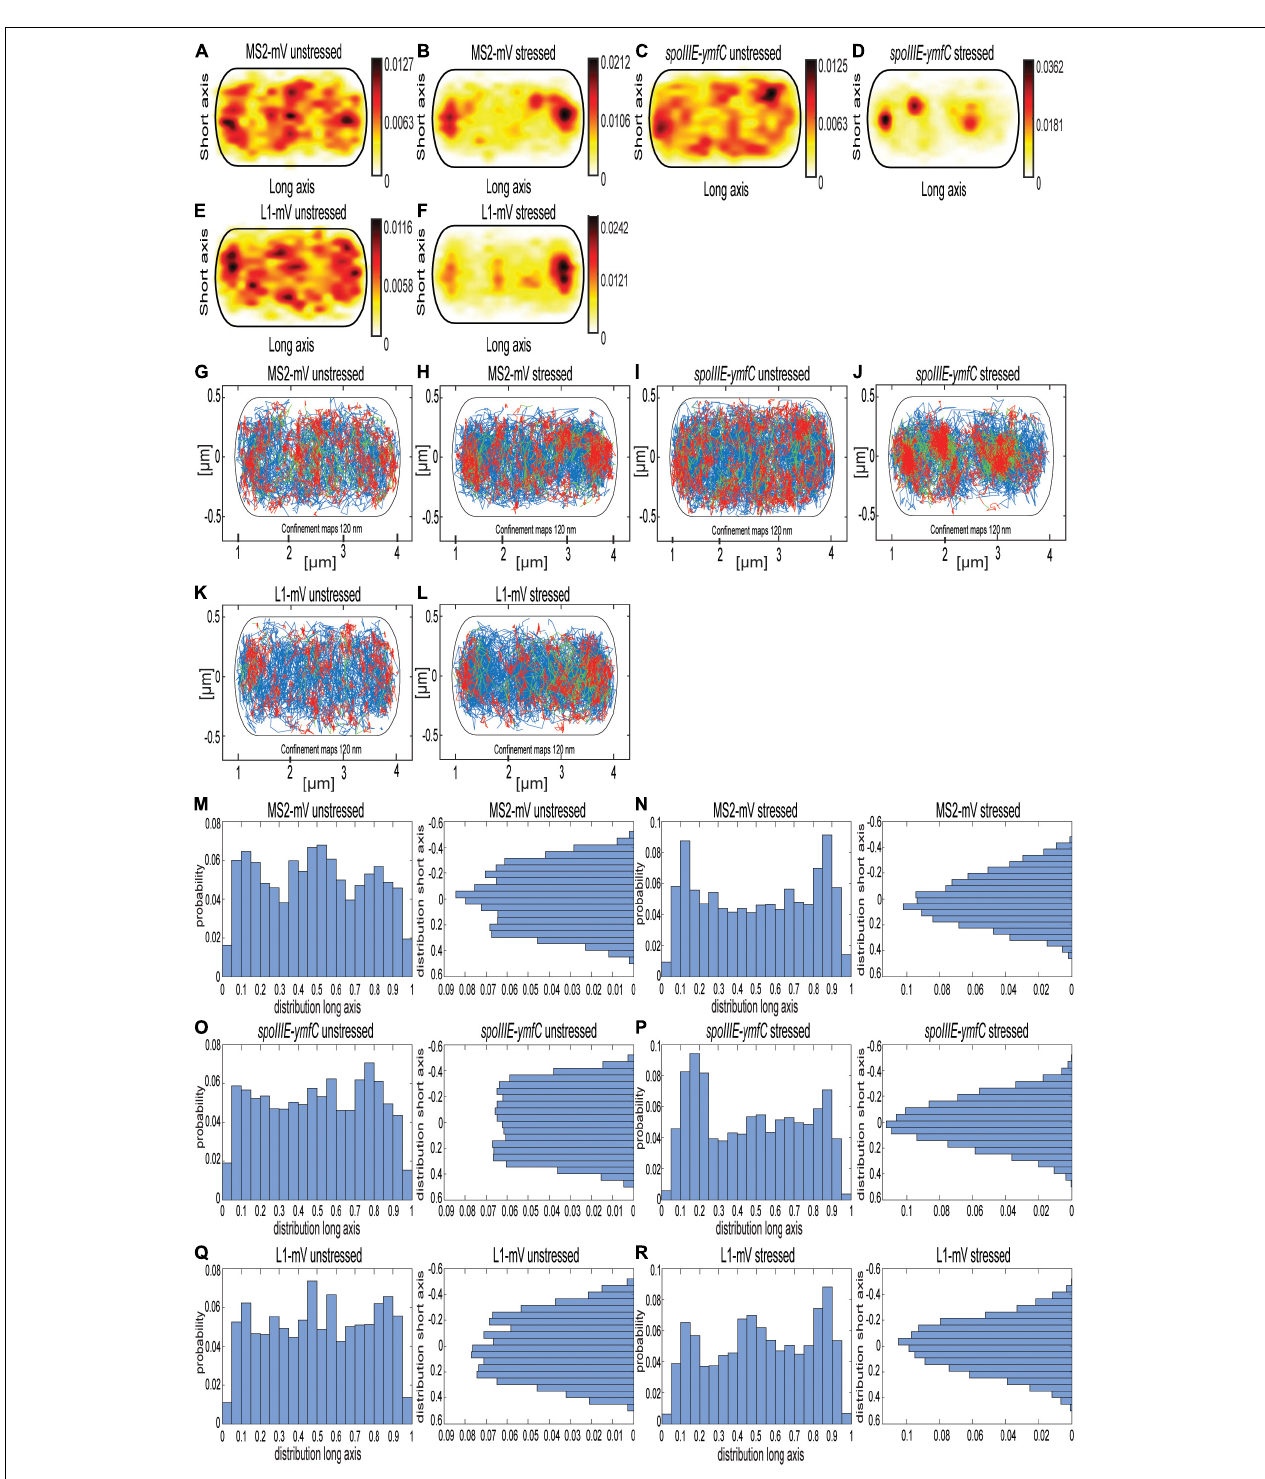
FIGURE 6 | Localization of MS2-mVenus, spoIIIE-ymfC , and L1-mVenus with and without 50 mg rifampicin. All tracks of MS2-mVenus alone (A,G) or bound to 2 × MS2-binding site tagged mRNA spoIIIE-ymfC (C,I) or the ribosomal protein L1-mVenus (E,K) are projected into a standardized cell of 1 × 3 µ m. (B,H) B. subtilis cells expressing MS2-mVenus alone stressed for 40 min with 50 µ g/mL rifampicin (D,J) or bound to 2 × MS2-binding site tagged mRNA spoIIIE-ymfC or (F,L) ribosomal protein L1-mVenus. (A–F) Heat maps, from white to red, low to the probability of localization of molecules. (G–L) Confinement maps, blue represents freely diffusive tracks, red tracks restricted to confined motion within a circle of 120 nm for a minimum of eight steps, and green tracks having mixed behavior. (M–R) , Histograms showing the probability of confined tracks occurring along long ( x ) or short ( y ) axis of cells. Histograms correspond to panels (G–L) .